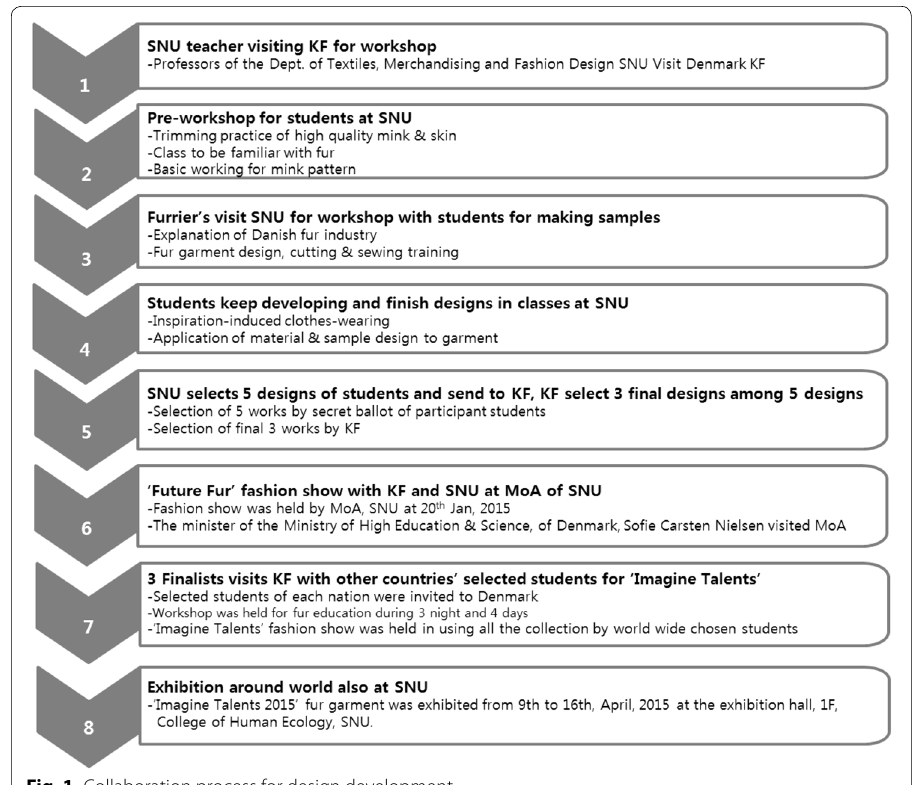
Fig. 1 Collaboration process for design